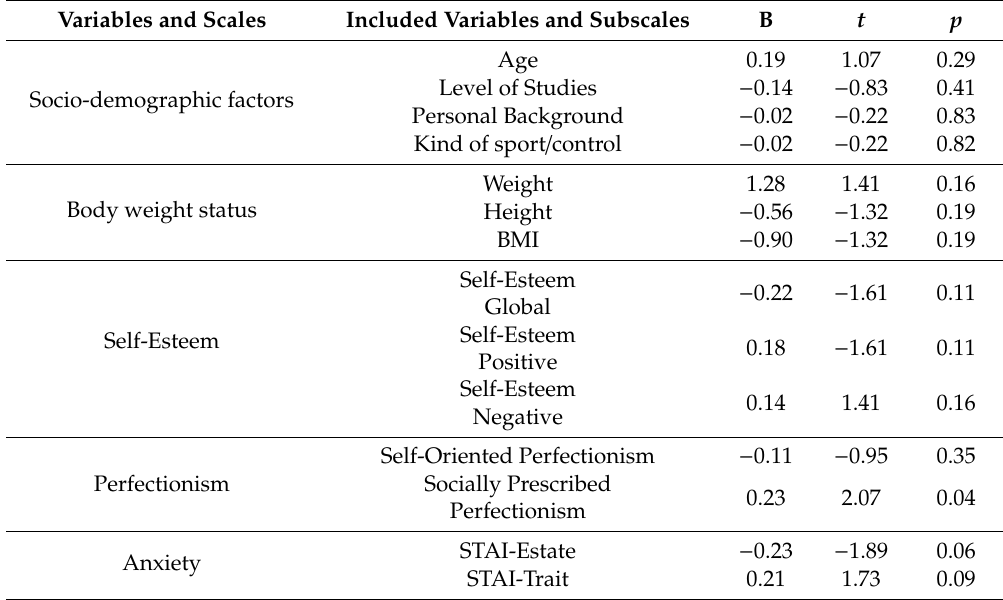
Table 2. Multiple Linear Regression of factor associated with eating disorders (SCOFF). Variables and Scales Included Variables and Subscales